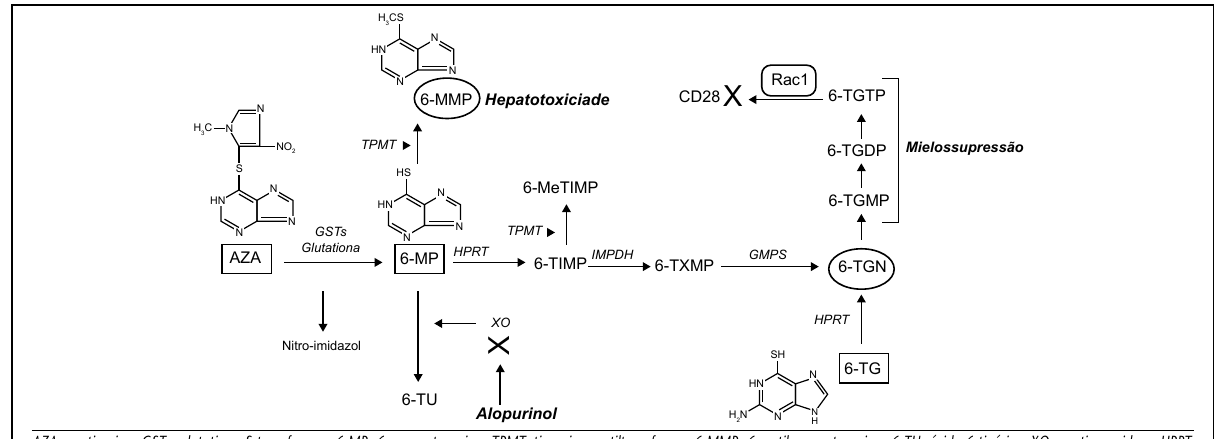
• ácido tioúrico (6-TU) pela ação da enzima xantina oxidase (XO) no fígado e na mucosa